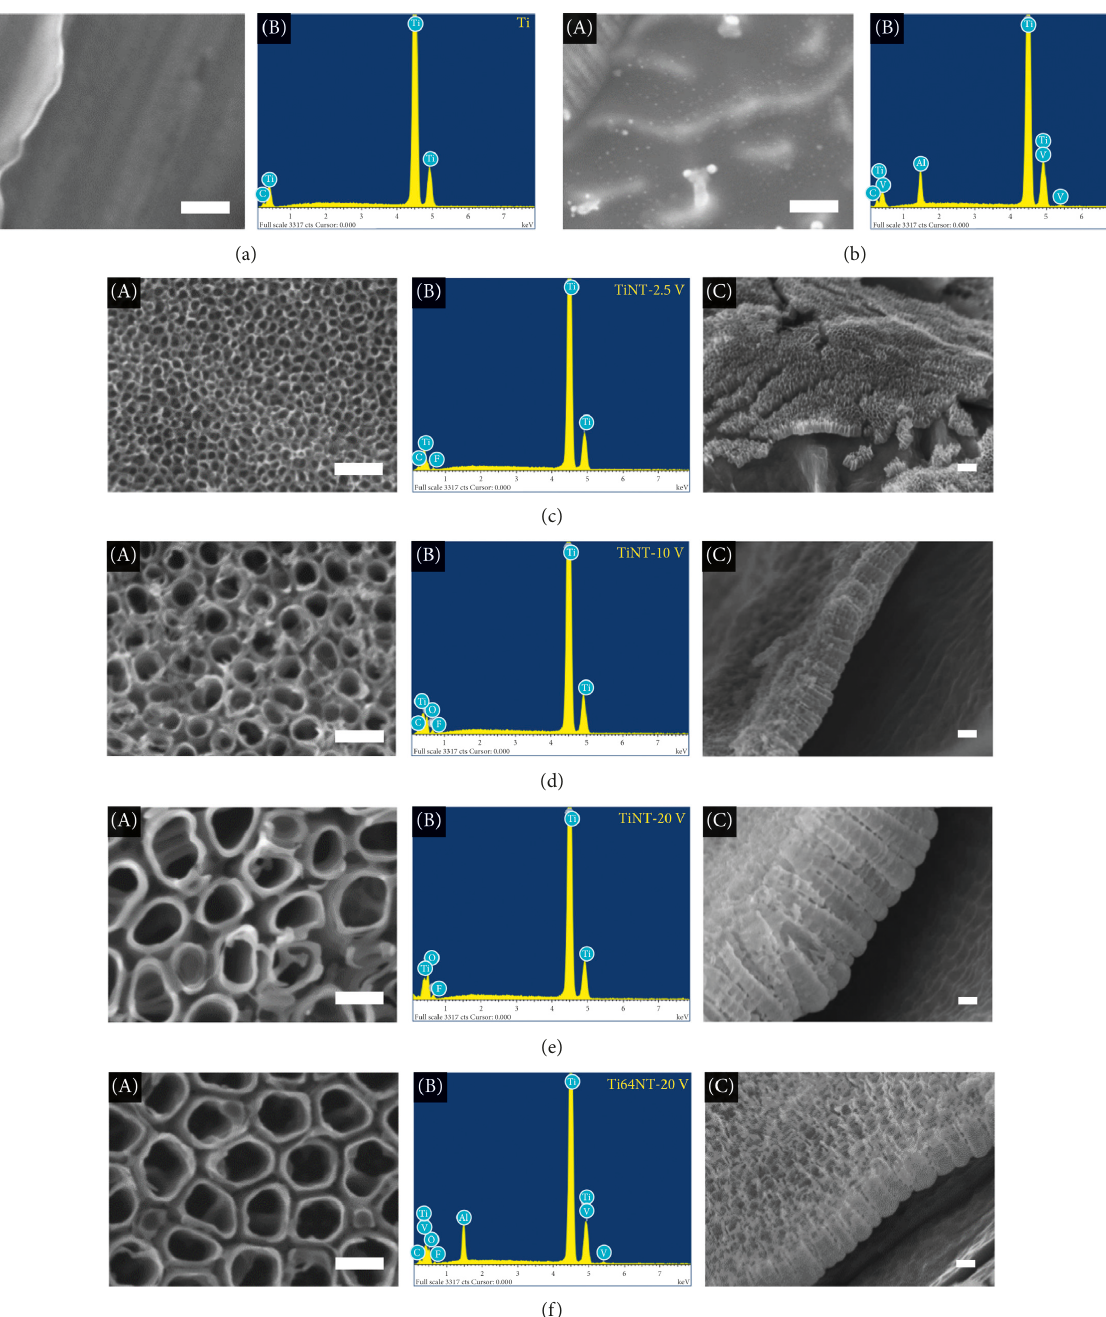
Figure 5: Top view FE-SEM micrographs (A); respective EDS analysis (B); cross sections of the nanotube layer (C); base material: pure titanium (a) and Ti-6Al-4V (b); anodised specimens (c)–(f). Scale bar 20V. (f)